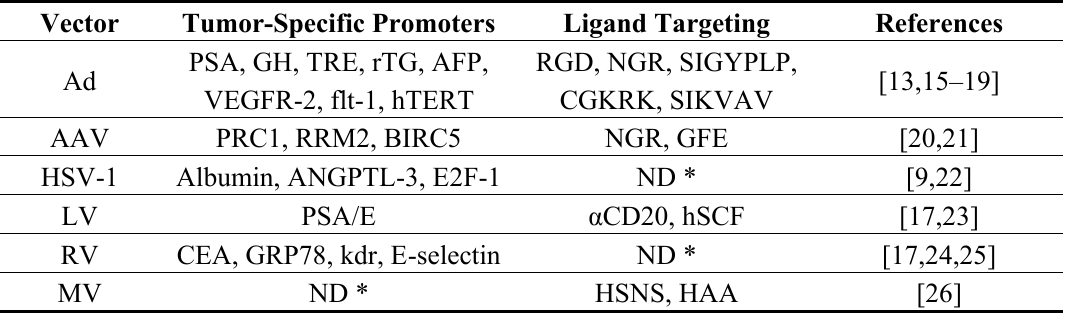
Table 1. Examples of ligand and transcriptional targeting used in eukaryotic viral vectors in targeted cancer